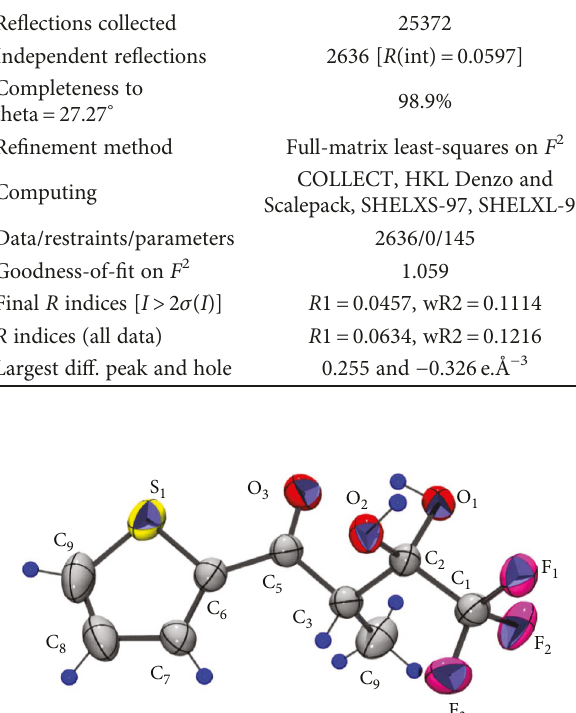
Figure 3: ORTEP-3 5 view of the 4,4,4-tri fl uoro-3,3-dihydroxy-2- methyl-1-(thien-2-yl)butan-1-one (3) with the corresponding atom numbers. Displacement ellipsoids are drawn at the 50% probability level with hydrogen atoms represented by small spheres of arbitrary radii.